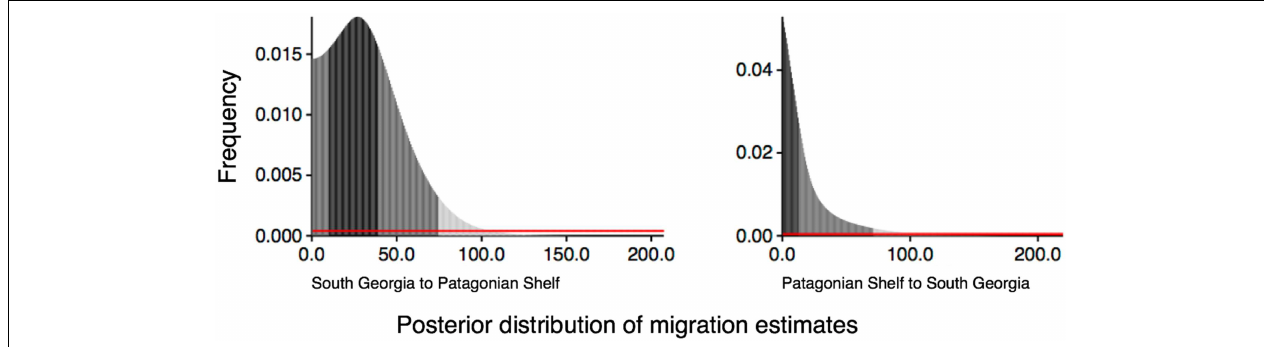
FIGURE 6 | The distribution of the posterior migration estimates from the analysis of the full migration model allowing migration between South Georgia to Patagonian shelf and Patagonian shelf to South Georgia.